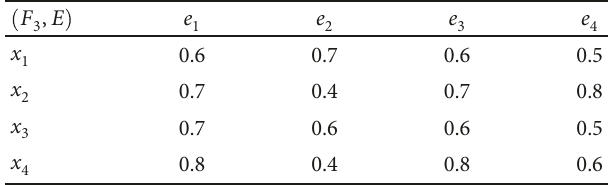
Table 13: The evaluation value of expert